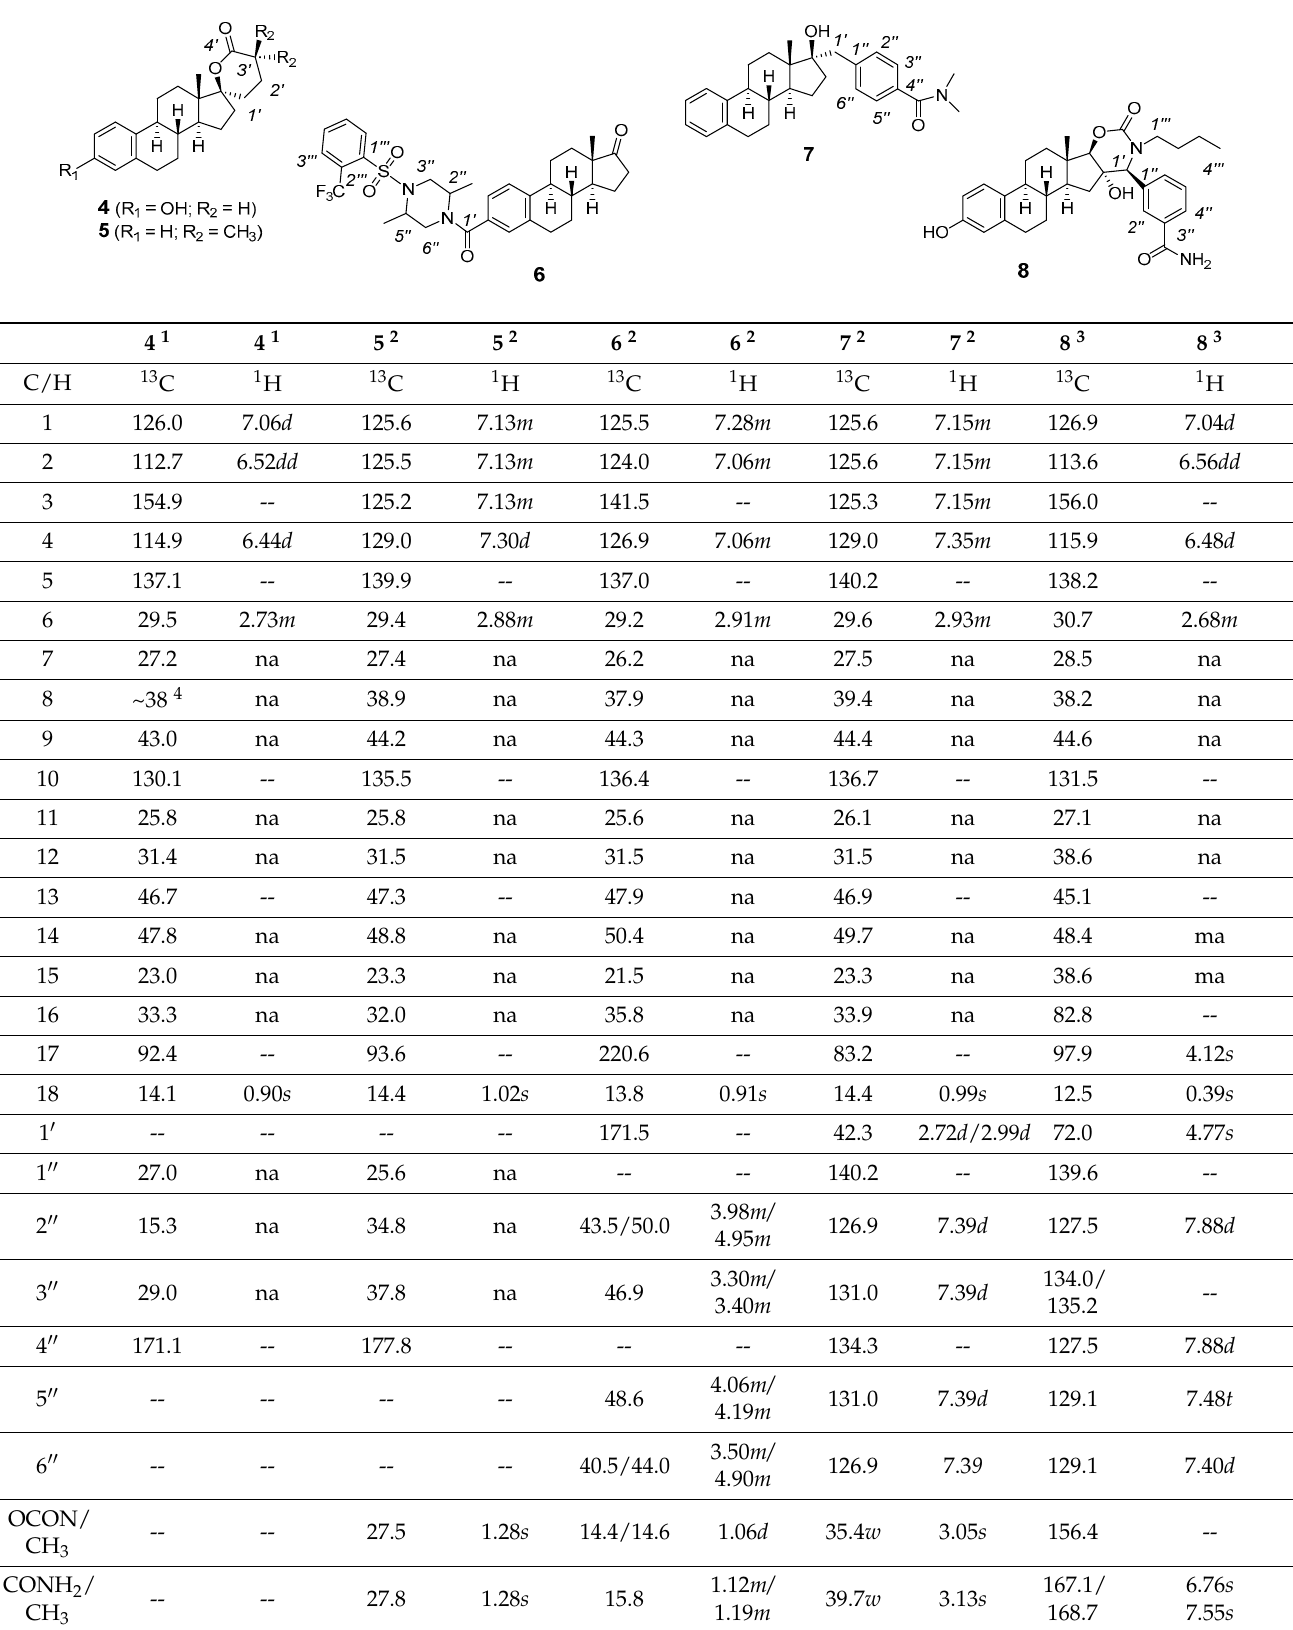
Table 2. NMR data for estrane-based steroid inhibitors 4 – 7 and activator 8 .